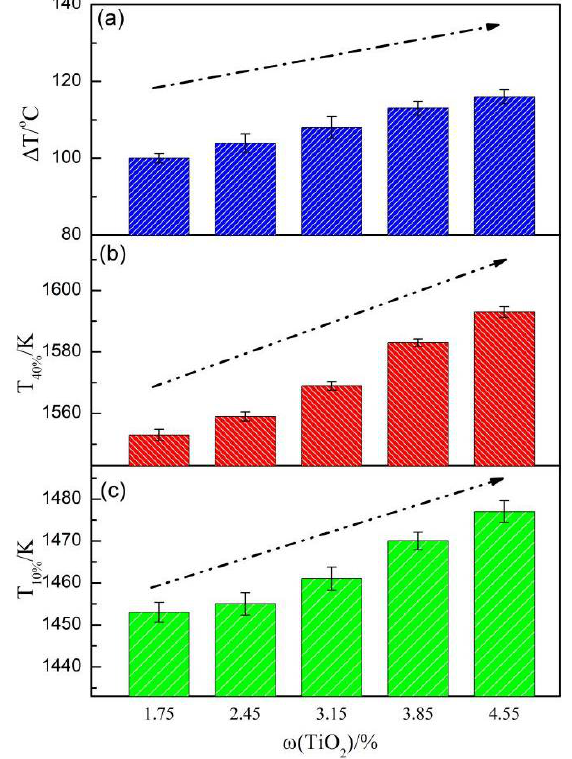
Figure 9. Softening index of the LVTM sinter with various TiO 2 contents: ( a ) ΔT, ( b ) T 40% , ( c ) T 10% .